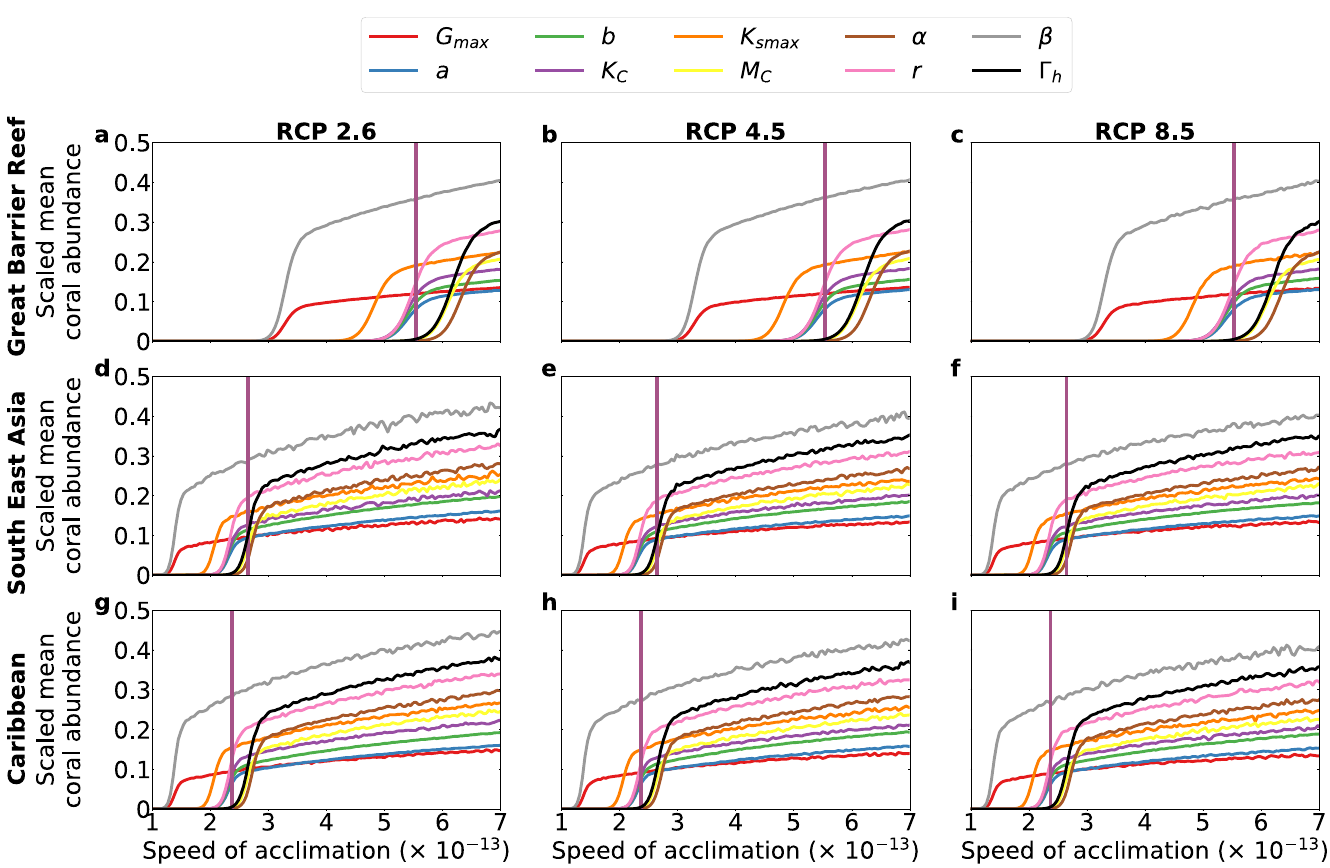
Fig 5. Sensitivity to speed of acclimation N for +25% change in each parameter. Simulations with bleaching. Vertical lines mark the speed of acclimation we estimated from coral cover data (see S2 Appendix).